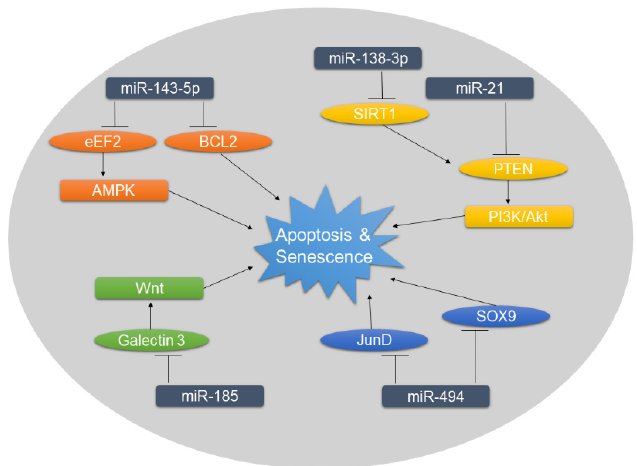
Figure 2. Overview of miRNAs associated with increased rates of apoptosis and senescence in DDD. Targets of negative miRNA regulation are shown in ellipses. The dysregulation of miRNAs and subsequently of their targets influence the downstream signaling, ultimately promoting apoptosis and senescence.